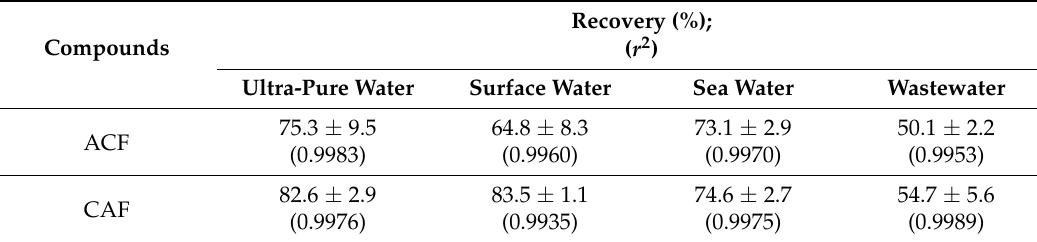
Table 2. Regression parameters obtained with the standard addition method (SAM) and average recovery yields for ACF and CAF in ultra-pure, surface, sea, and wastewater matrices obtained